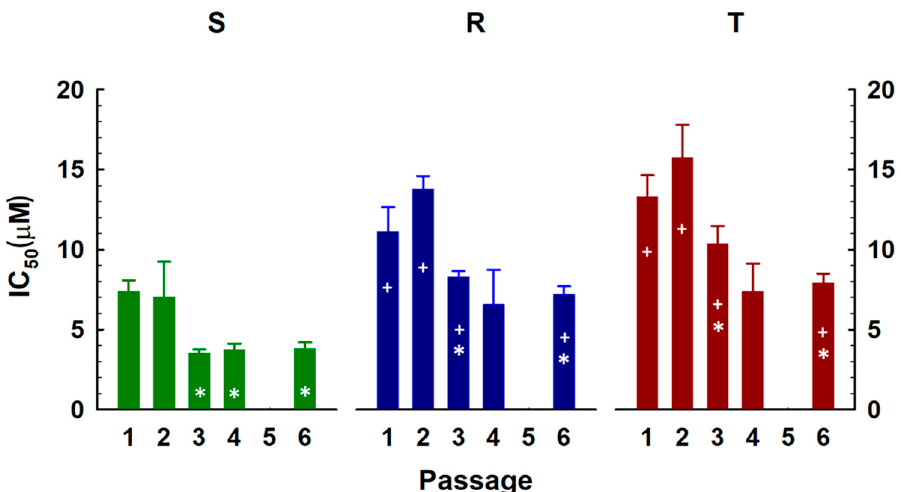
Figure 4. IC 50 changes induced by repeated cultivations in SFN-containing medium. Data were calculated by nonlinear regression of the dose ‒ response curves according to Equation (1). Data represent calculated SD values for 44 degrees of freedom. Significance: + data differ from S cells at the levels p < 0.02; * data differ from control at the absence of SFN at the level p < 0.02.